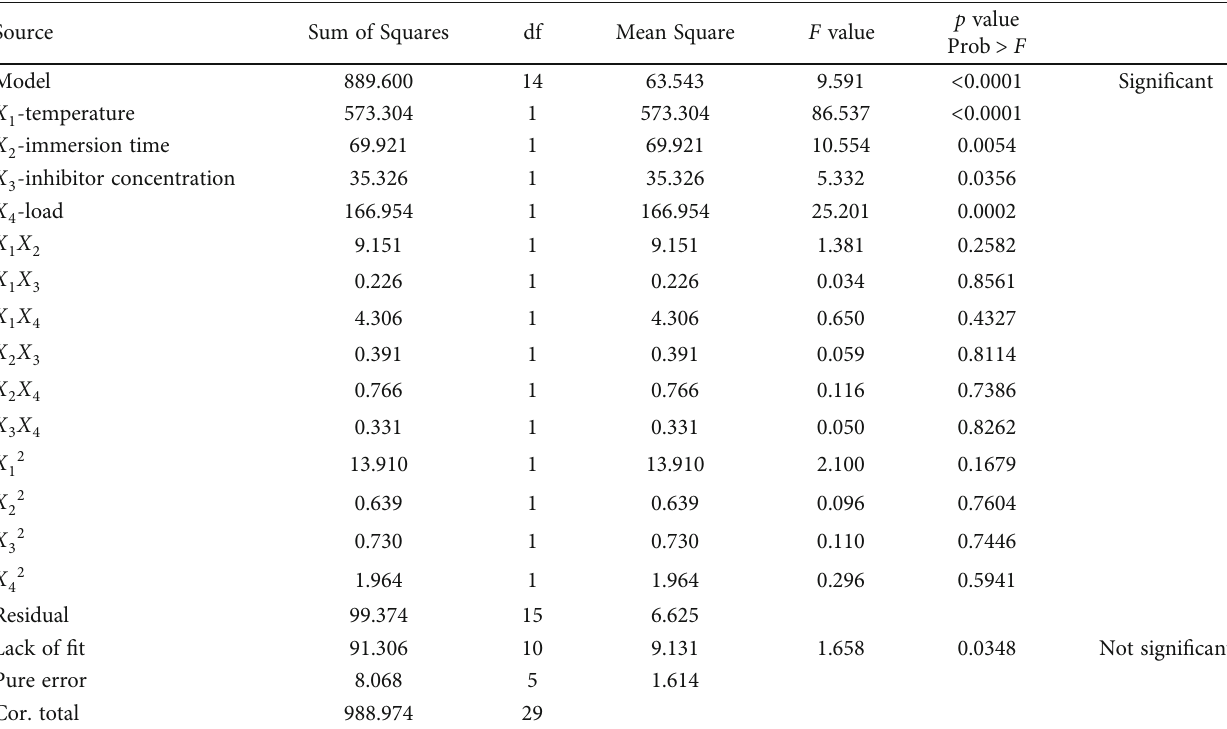
Figure 9: Hardness experimental versus predicted Table 9: Type III ANOVA result for hardness.